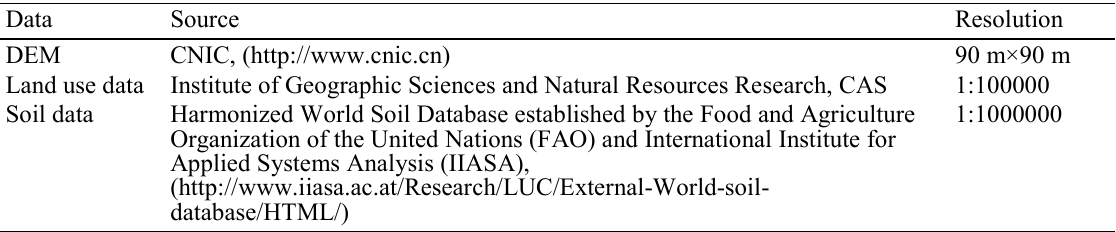
Table 1 Geo-spatial data used in PRMS